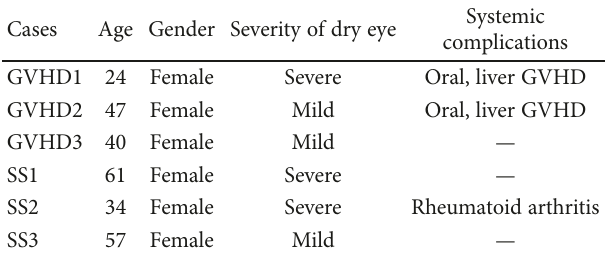
Table 1: Patient characteristics in this study.